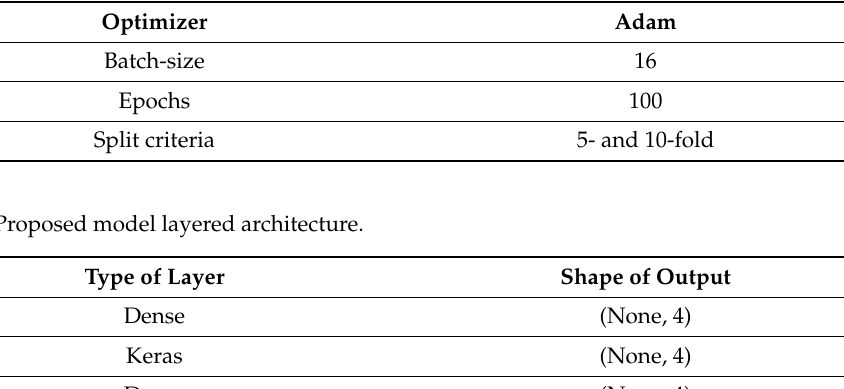
Table 3. Proposed model layered architecture.